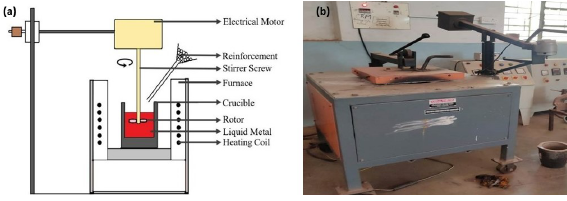
Figure 3: (a) Schematic diagram of Stir casting set up and (b) Photo of stir casting set